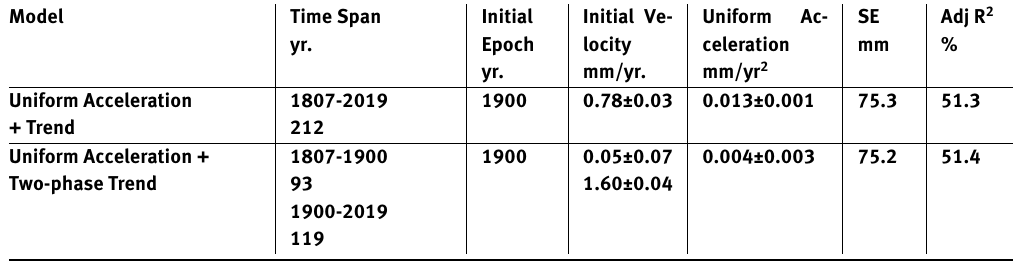
Table 2. OLS solution statistics. Trend and uniform acceleration estimates in bold are statistically significant at α = 0.05.